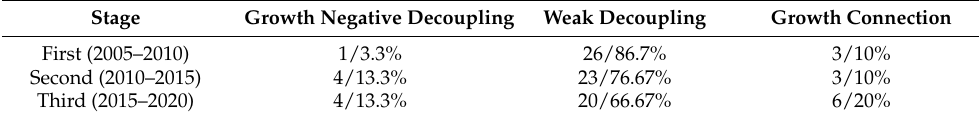
Table 4. Number (pcs) and proportion of different decoupling types in each period.